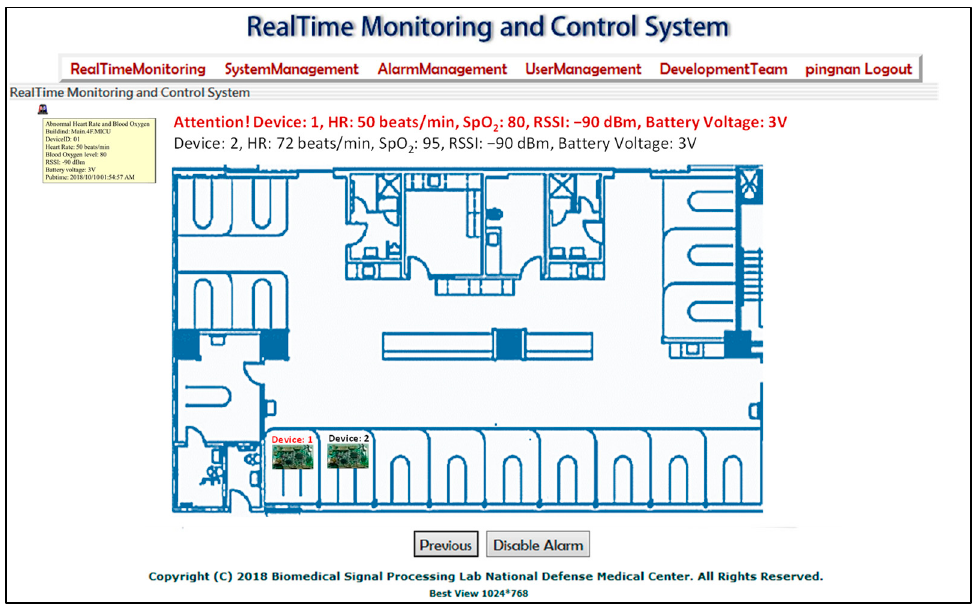
Figure 13. Level 4 includes the real-time monitoring of the physiological parameters of MICU pa- tients.